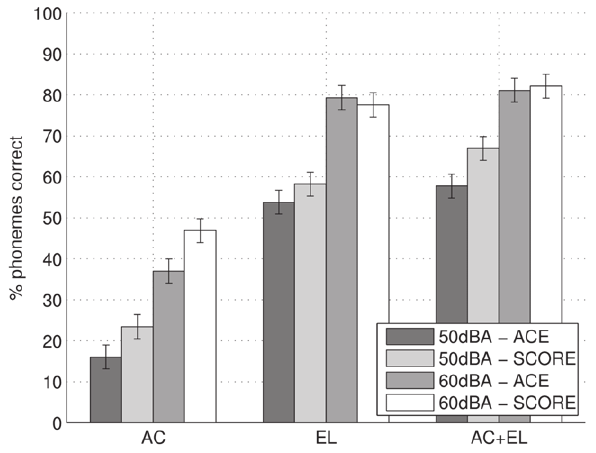
Figure 6. Speech in noise results averaged across subjects. The total error bar length indicates Fletcher’s least significant